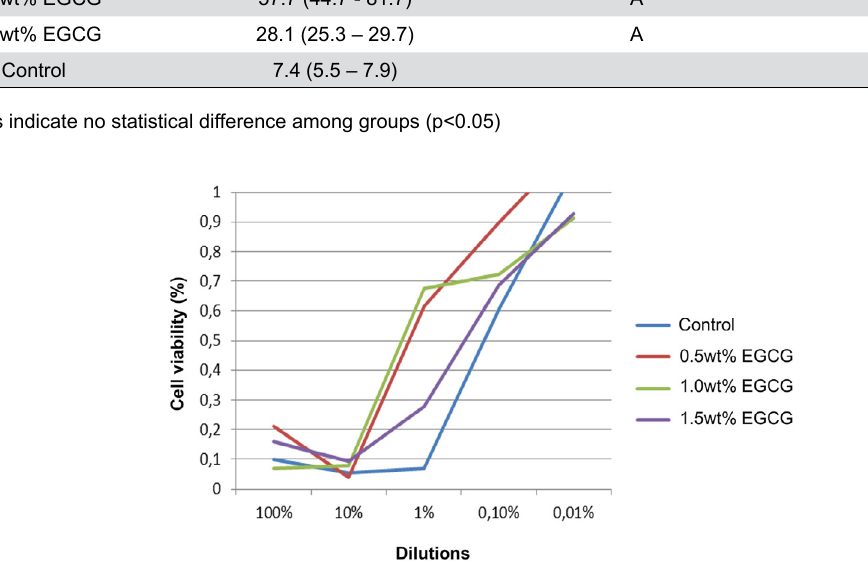
Figure 1- Graph of the viability curves (in percentages) of fibroblasts cells in serial dilutions of the adhesives